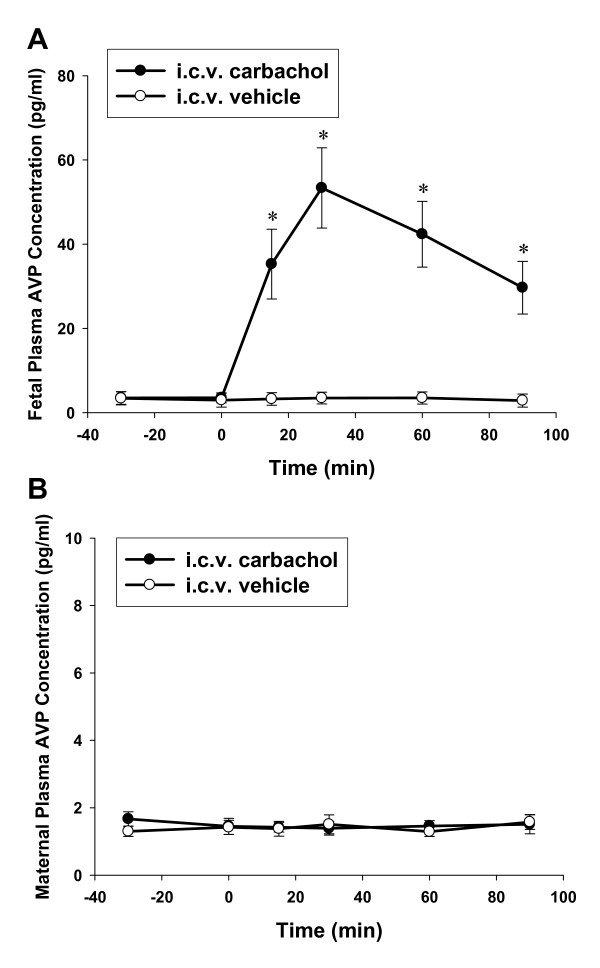
The effect of i.c.v. carbachol on fetal (A) and maternal (B) plasma AVP concentration. The dose of carbachol, 3 μg/kg; 0 min: time for i.c.v. injection. *, P < 0.01 compared with the baseline level. AVP: arginine vasopressin.